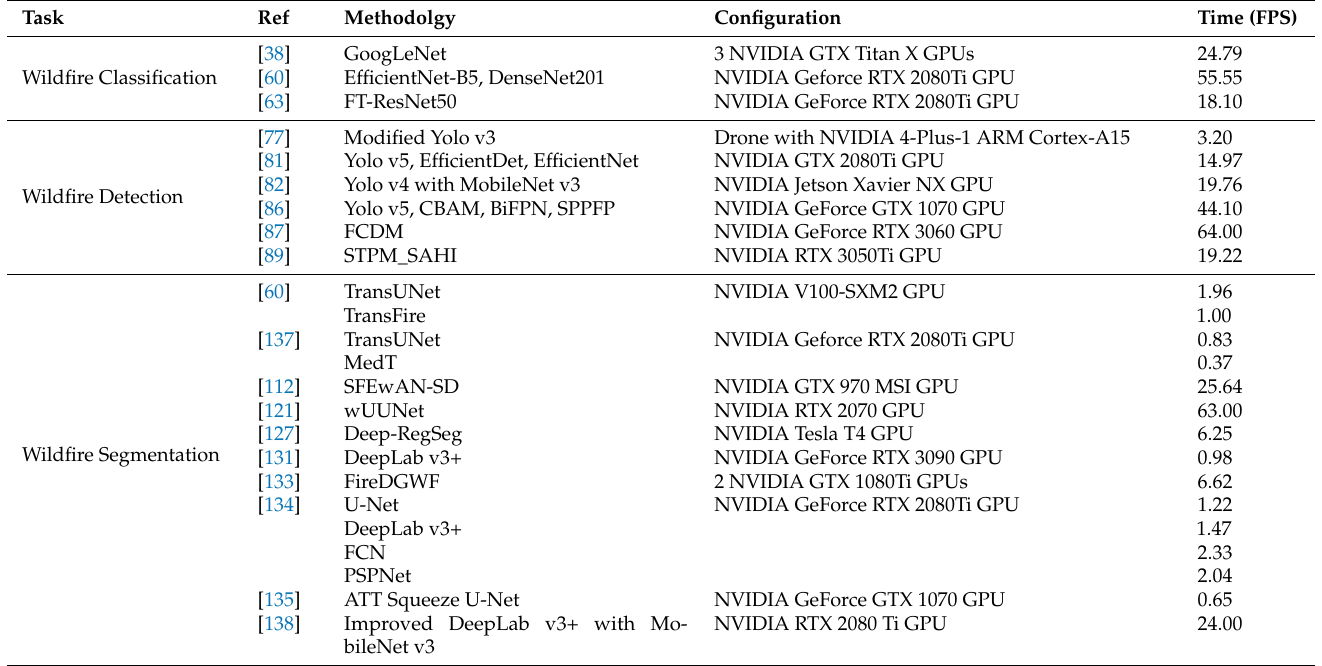
Table 6. Overview of inference